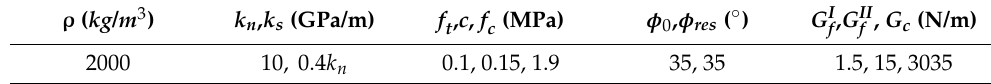
Table 2. Contact properties used in D-RBA.